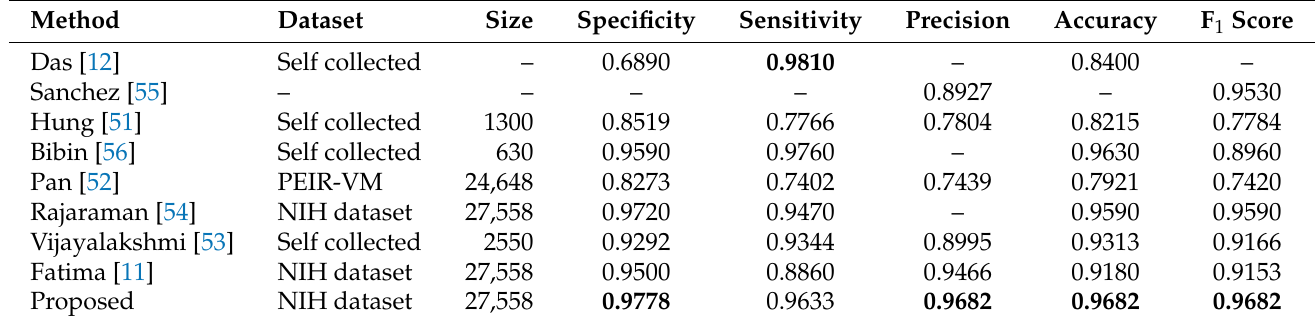
Table 4. Performance comparison of the proposed and the compared methods. Size represents the number of images in the dataset. The best results are marked in